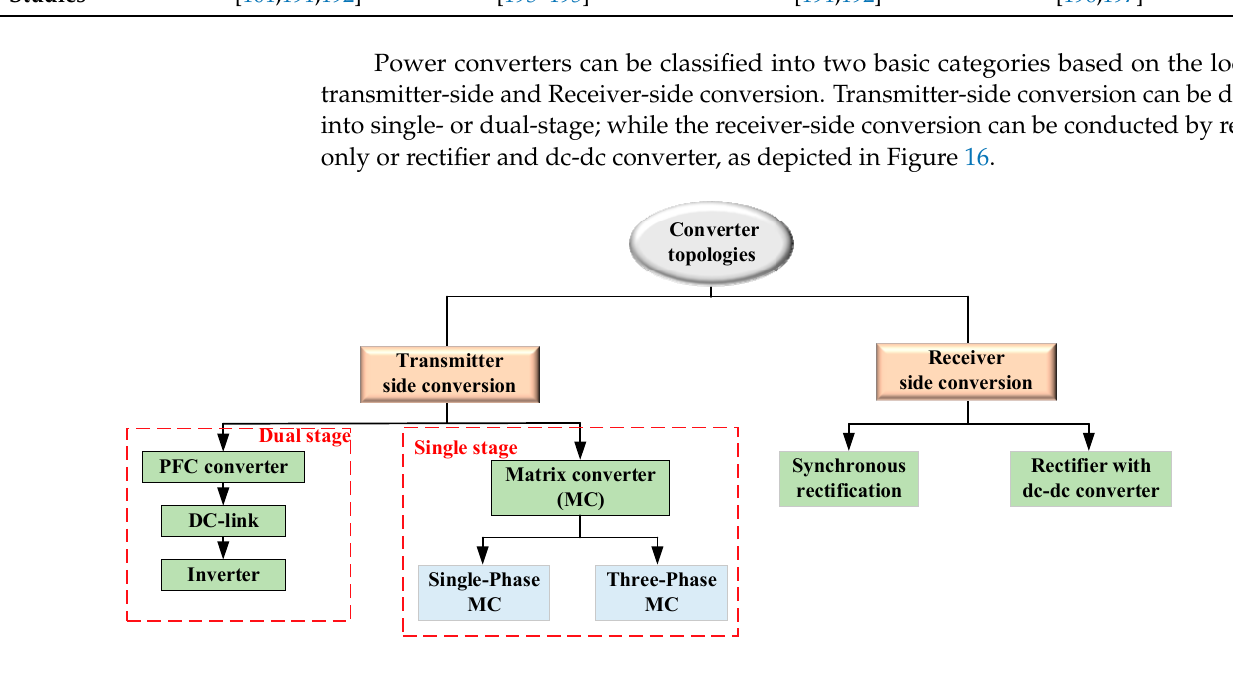
Figure 16. Categorization of converter topologies for DIPT.